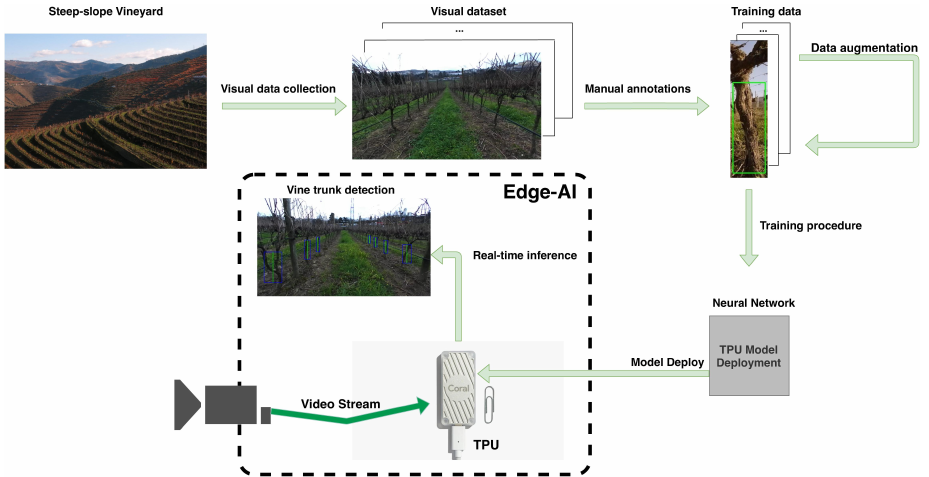
Figure 3. High-level design of the vine trunk detection framework. The procedure starts with the data acquisition in real-world vineyards, followed by the manual vine trunk annotation. The VineSet is extended using data augmentation techniques to increase the dataset size. Finally, the Neural Networks are trained and deployed in a Edge-AI manner, using dedicated